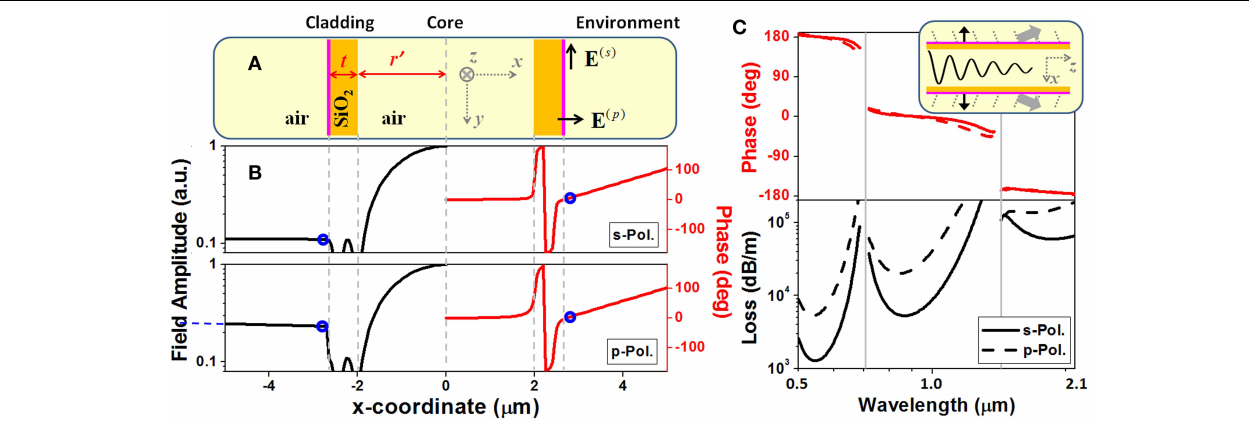
FIGURE 1 | (A) Schematic of an M-type slab waveguide. (C) Phase of electric field at the outermost boundary (the pink lines in (B) Distributions of the amplitudes (logarithmic scale) and the phases of the insert) and attenuation of the fundamental core mode as a function the major electric field components in the s and p polarizations ( E y and of the wavelength. The gray lines in (C) stand for the resonant E x , respectively). r ′ 2 µ m, t 0 . 67 µ m, n 2 1 . 45 , and λ 0 0 . 938 µ m. = = = =